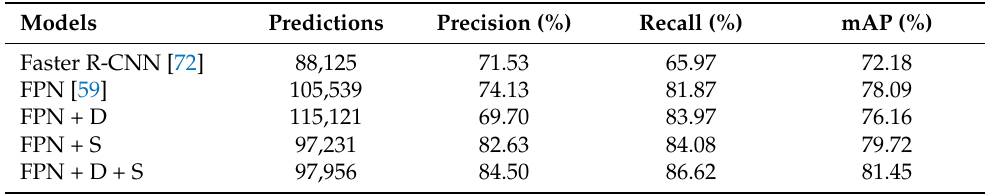
Table 1. Model comparison (threshold = 0.5). D: domain knowledge integration. S: scale- aware